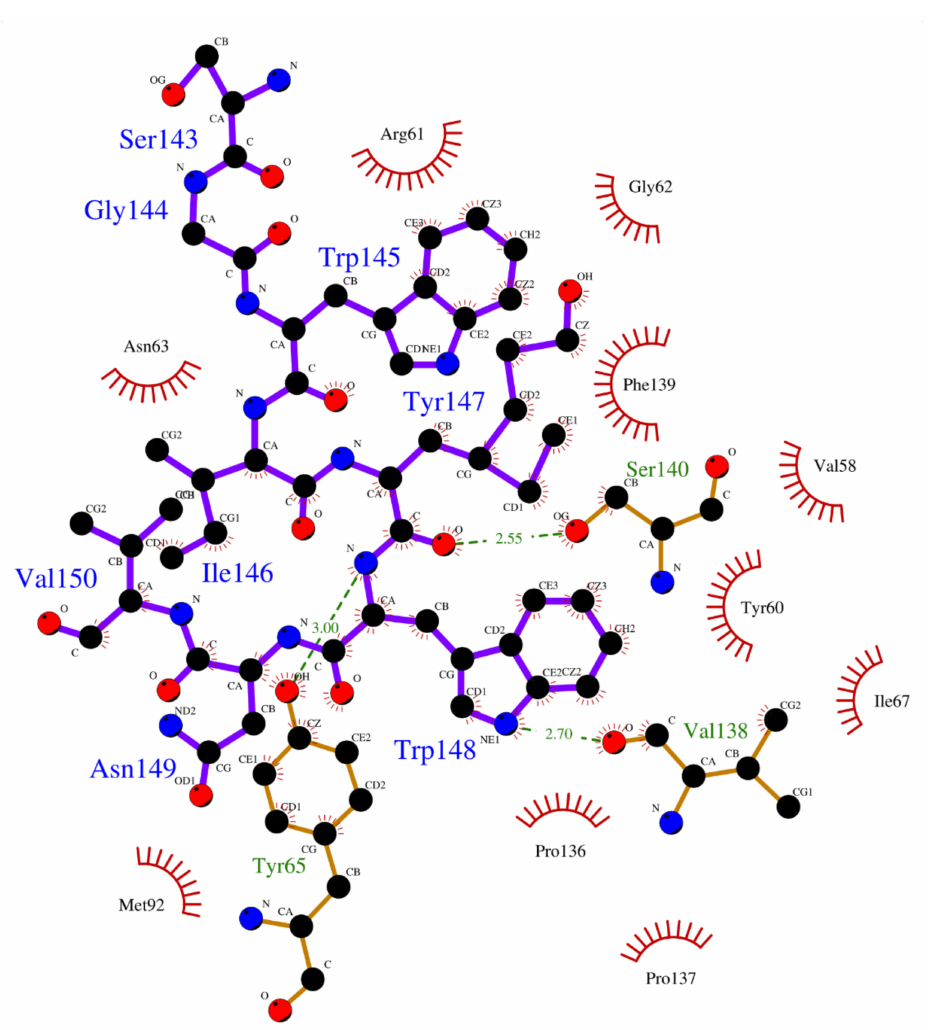
Figure 7. Overview of binding modes of the UEV domain proteins with